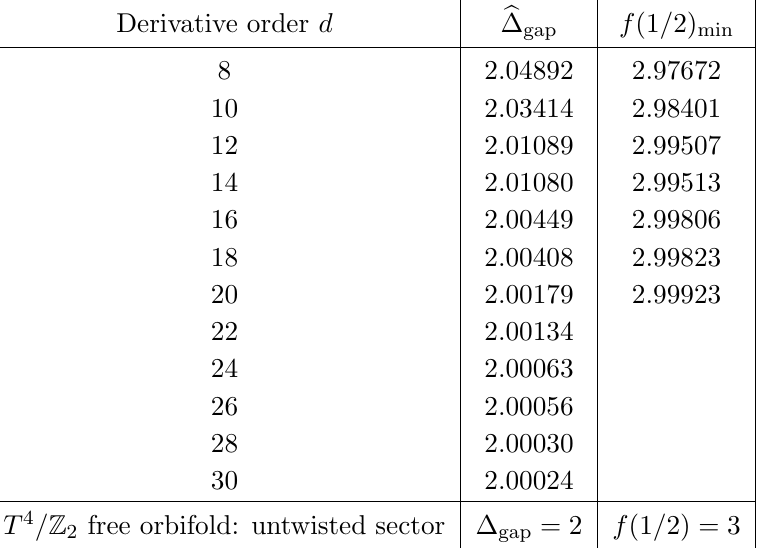
Table 2 . The bound on the gap in the identical primary OPE, and the minimal value of the four- point function evaluated at the crossing symmetric point, as the derivative order of the basis of functionals is increased. Also shown are the values of the untwisted sector correlator at the T 4 = Z 2 free orbifold point computed in section 6.1, which within numerical error saturate the